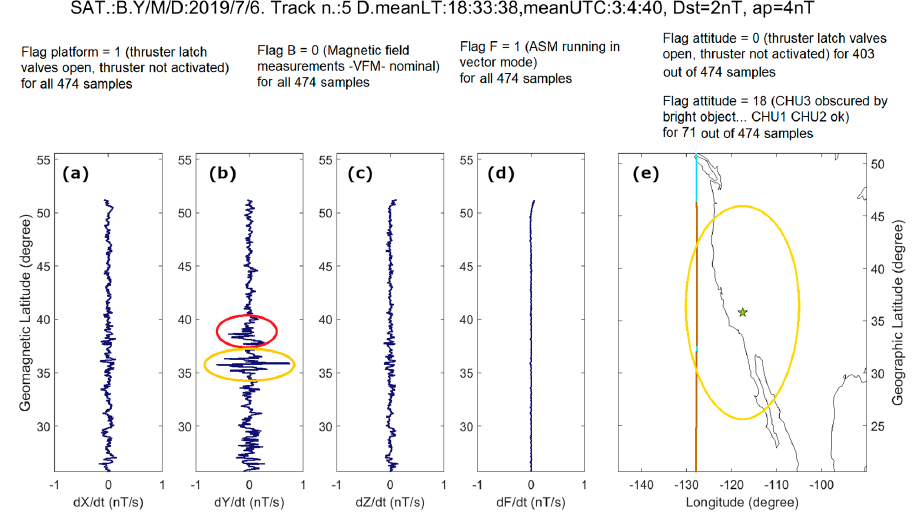
Figure 1. Magnetic data from Swarm Bravo track number 5 on 6 July, 2019. The track preceded the earthquake occurrence by about 15 minutes. Panels ( a – d ) show the residuals for first differences of X, Y, Z and absolute scalar intensity of the magnetic field, respectively. Panel ( e ) represents a geographical map of the investigated region, with the projection of the satellite track (the colour is related to Flag conditions), the epicentre of the Ridgecrest earthquake (green star) and the Dobrovolsky’s area (yellow circle). The red and orange circles underline two disturbances on the Y component of the magnetic field. Some detailed information about the Flags related to this track is also provided.